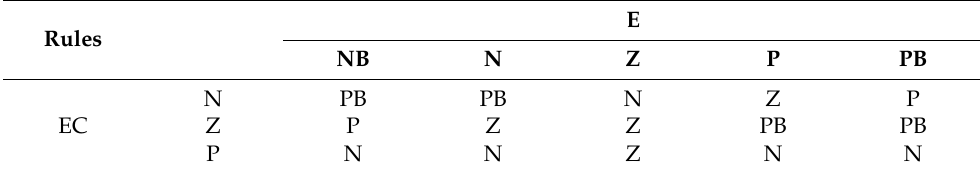
Figure 8. MFs of input and output variables. ( a ) MFs of input variable E ; ( b ) MFs of input variable EC ; ( c ) MFs of output variable U . Table 2. T-S fuzzy rules of the